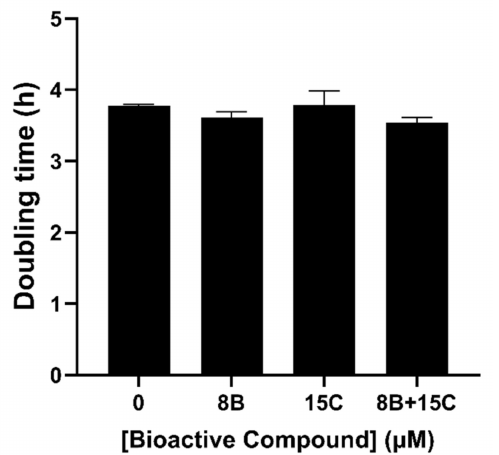
Figure 5. Doubling time of BY4743 [pYEX.A β ] after exposure to 8 µ M baicalein (8B), 15 µ M trans - chalcone (15C) and their combination (8B + 15C) in minimal media supplemented with the aux- otrophic requirements of the strain.